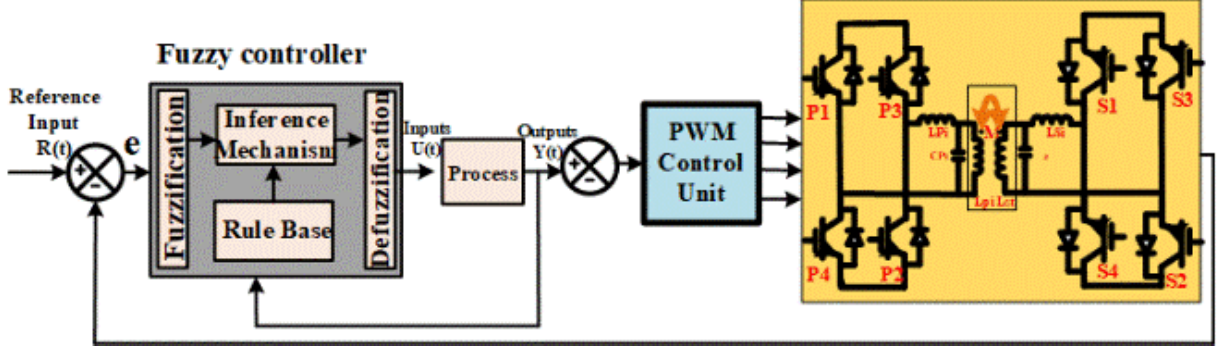
Figure 12. Fuzzy-Logic Controller-interfaced BWPT system.